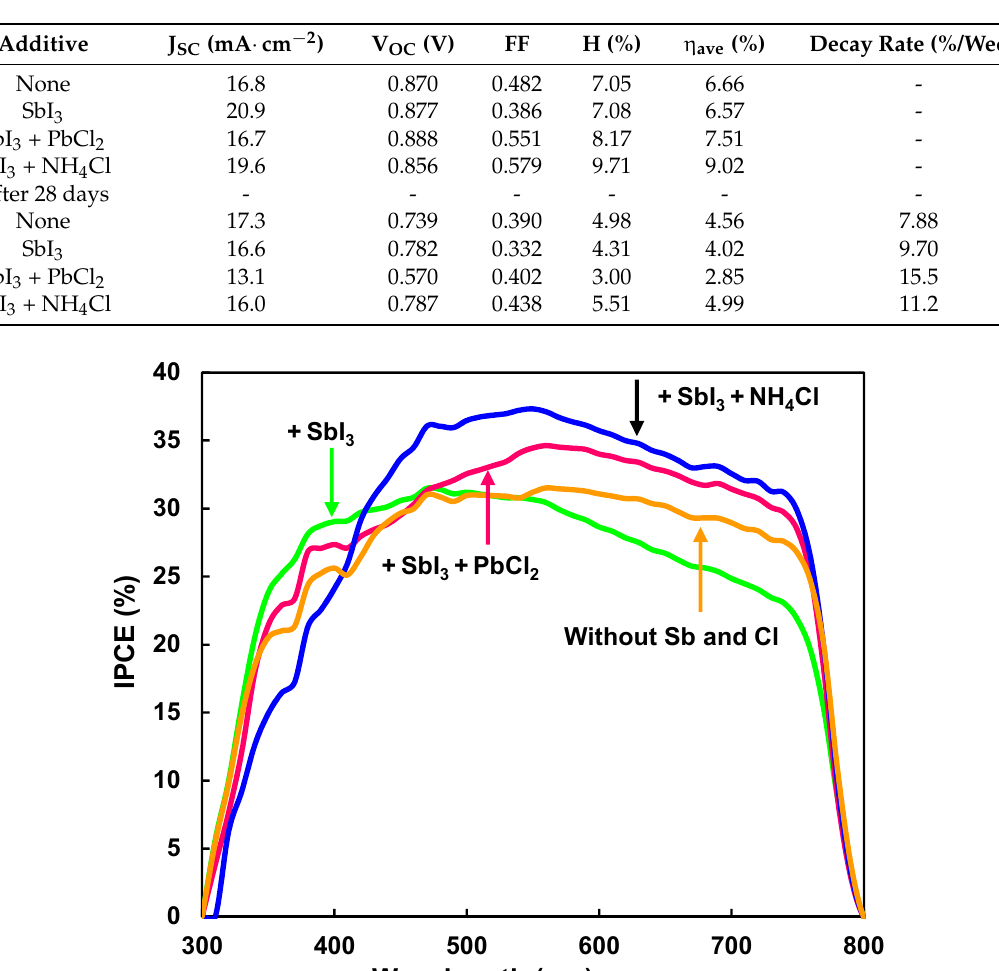
Figure 3. IPCE (incident photon-to-current conversion efficiency) spectra of CH 3 NH 3 Pb(Sb)I 3 (Cl) cells. Optical microscope images of CH 3 NH 3 PbI 3 , CH 3 NH 3 Pb(Sb)I 3 (Cl) added with SbI 3 , SbI 3 with